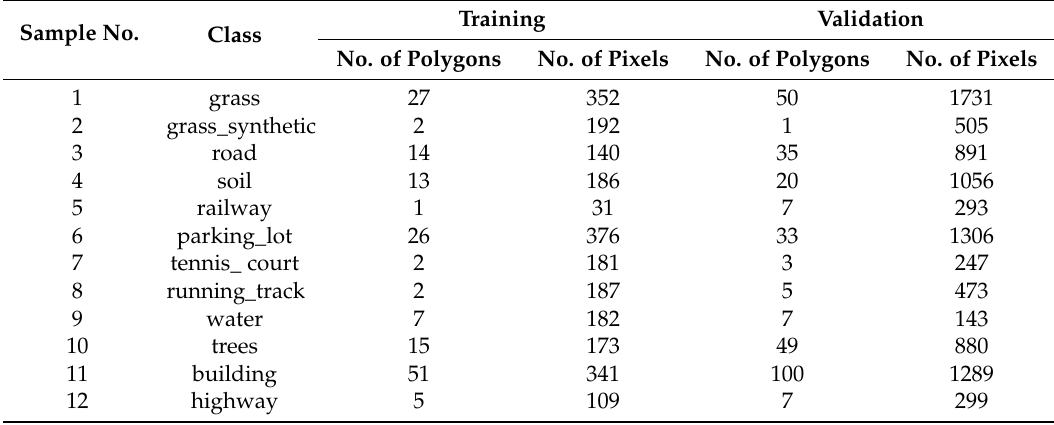
Table 1. Details of training and validation samples used for